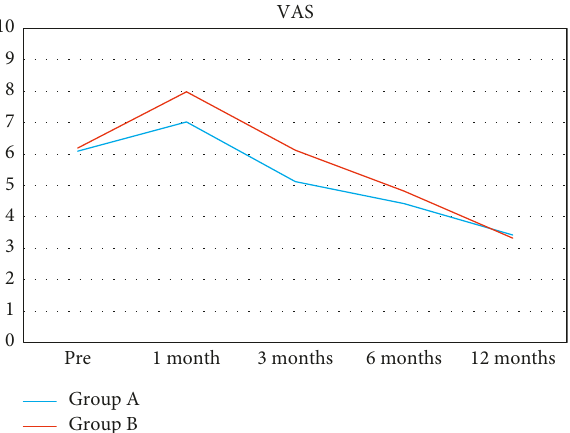
Figure 5: VAS (visual analogue scale) score evolution over time in the two cohorts: repeated VAS score analyses showed a significant and comparable reduction of pain intensity for both groups started one month after surgery.